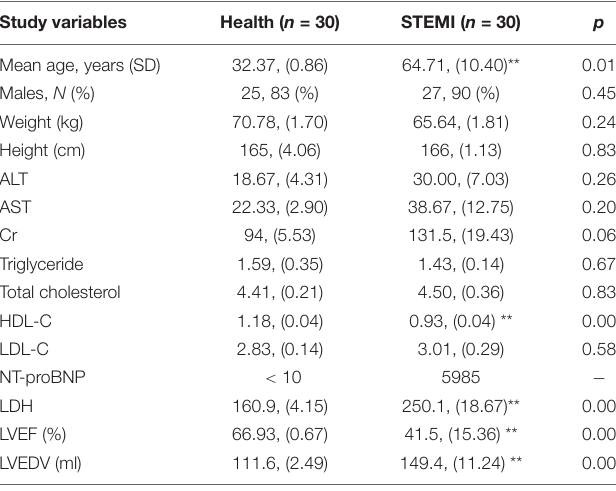
TABLE 1 | Characteristics of patients 3–6 months after ST-segment elevation myocardial infarction (STEMI) and healthy volunteers